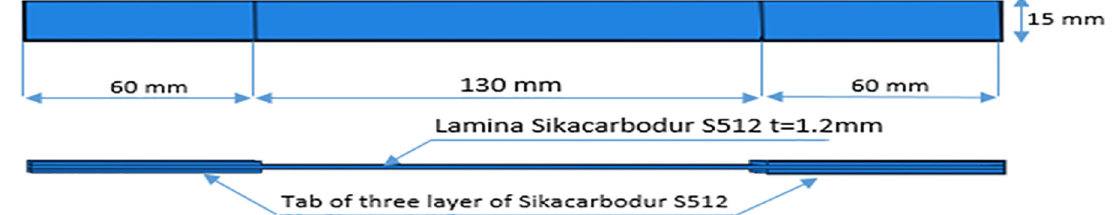
Figure 1. Carbon Fiber Reinforced Polymer standard tensile test sample.